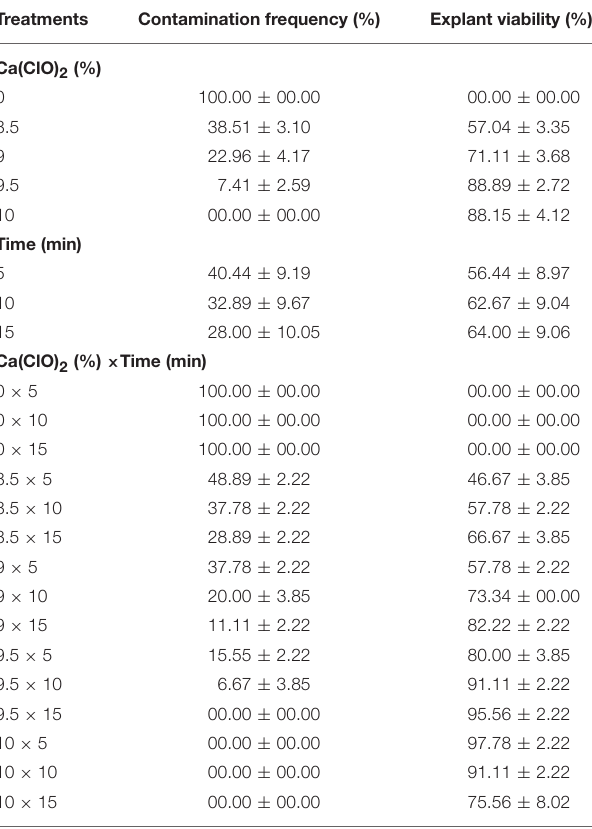
TABLE 3 | Effect of different concentrations of HgCl 2 at various immersion times on in vitro sterilization of chrysanthemum.